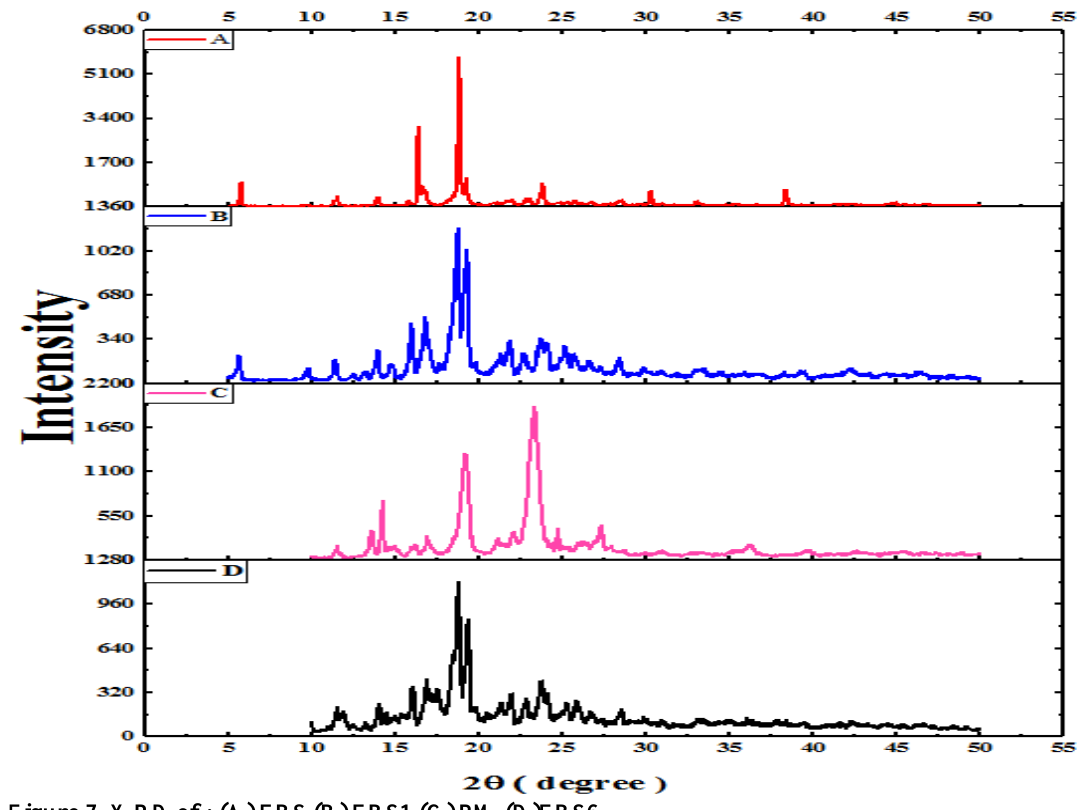
Figure 7. X.RD of : (A) EBS (B) EBS1 (C) PM (D)EBS6 Differential scanning calorimetry